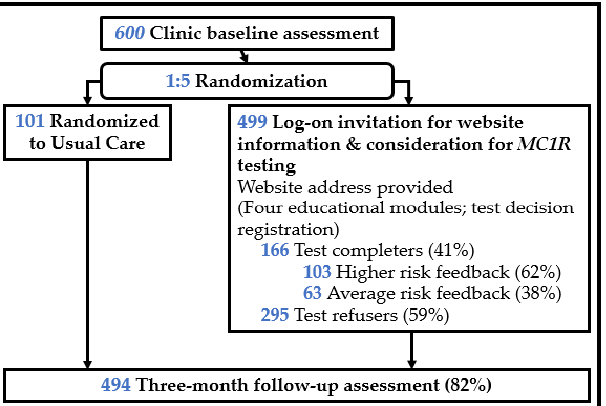
Figure 1. Study design. Note: of the 499 who received a log-on invitation, 37 requested but did not return a kit, and 1 returned a kit but no risk level was recorded.